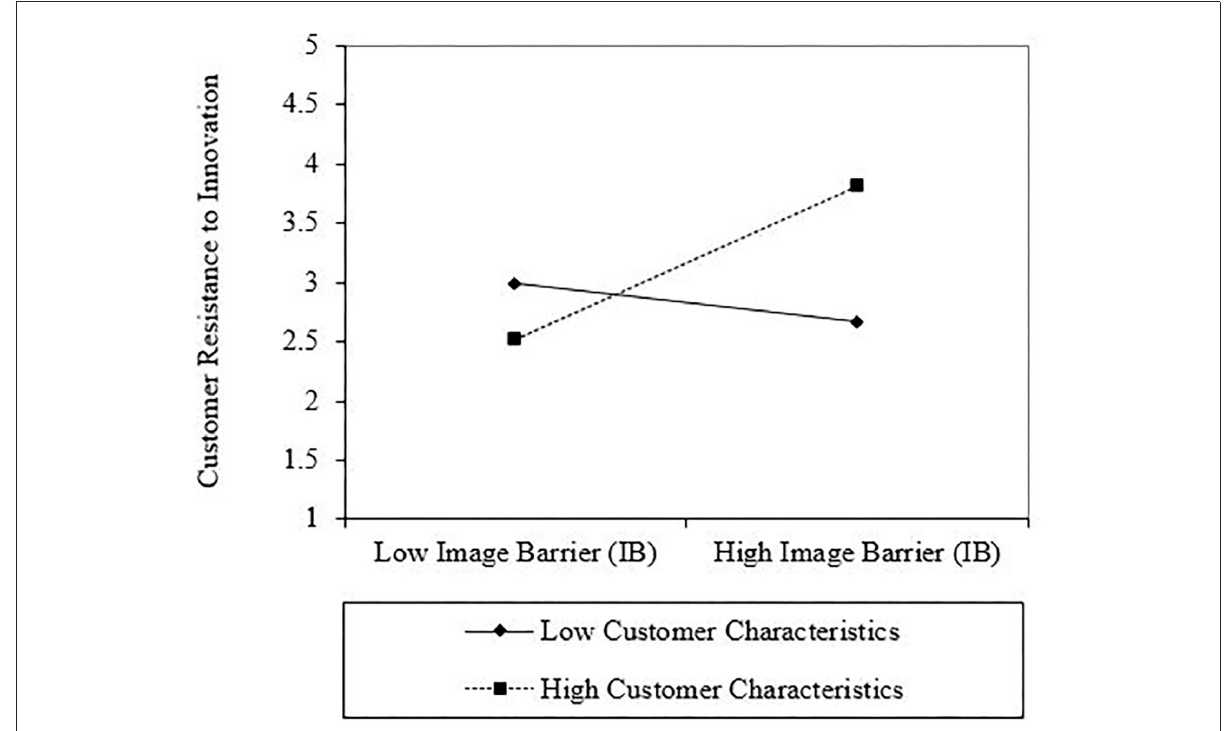
FIGURE4 Interaction plot of tradition barrier (IB) and customer characteristics interaction on the customer resistance to